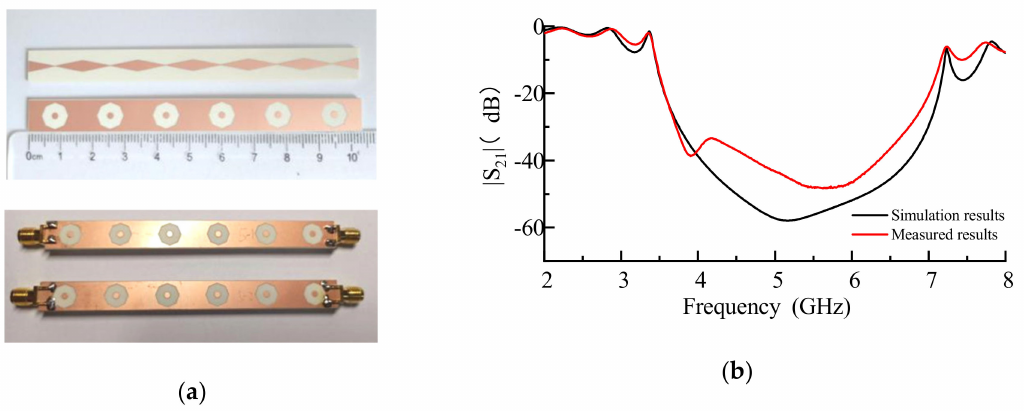
Figure 15. ( a ) Physical photographs of microstrip band stop filter etched periodic octagonal ring EBGs welding with SMA joint; ( b ) comparison of the measured and simulated results of the filter etched periodic octagonal ring